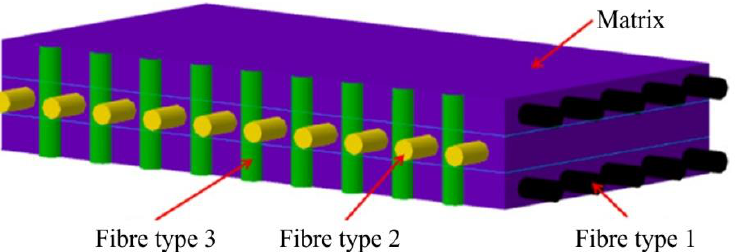
Figure 10. Schematic 3D diagram of the structure of fibre reinforced composite with fibres oriented in the matrix in three orthogonal directions: longitudinal (type 1), crosswise (type 2), and through the thickness of the matrix (type 3) (adapted with permission from Ref. [88], 2021, copyright Elsevier Ltd.).